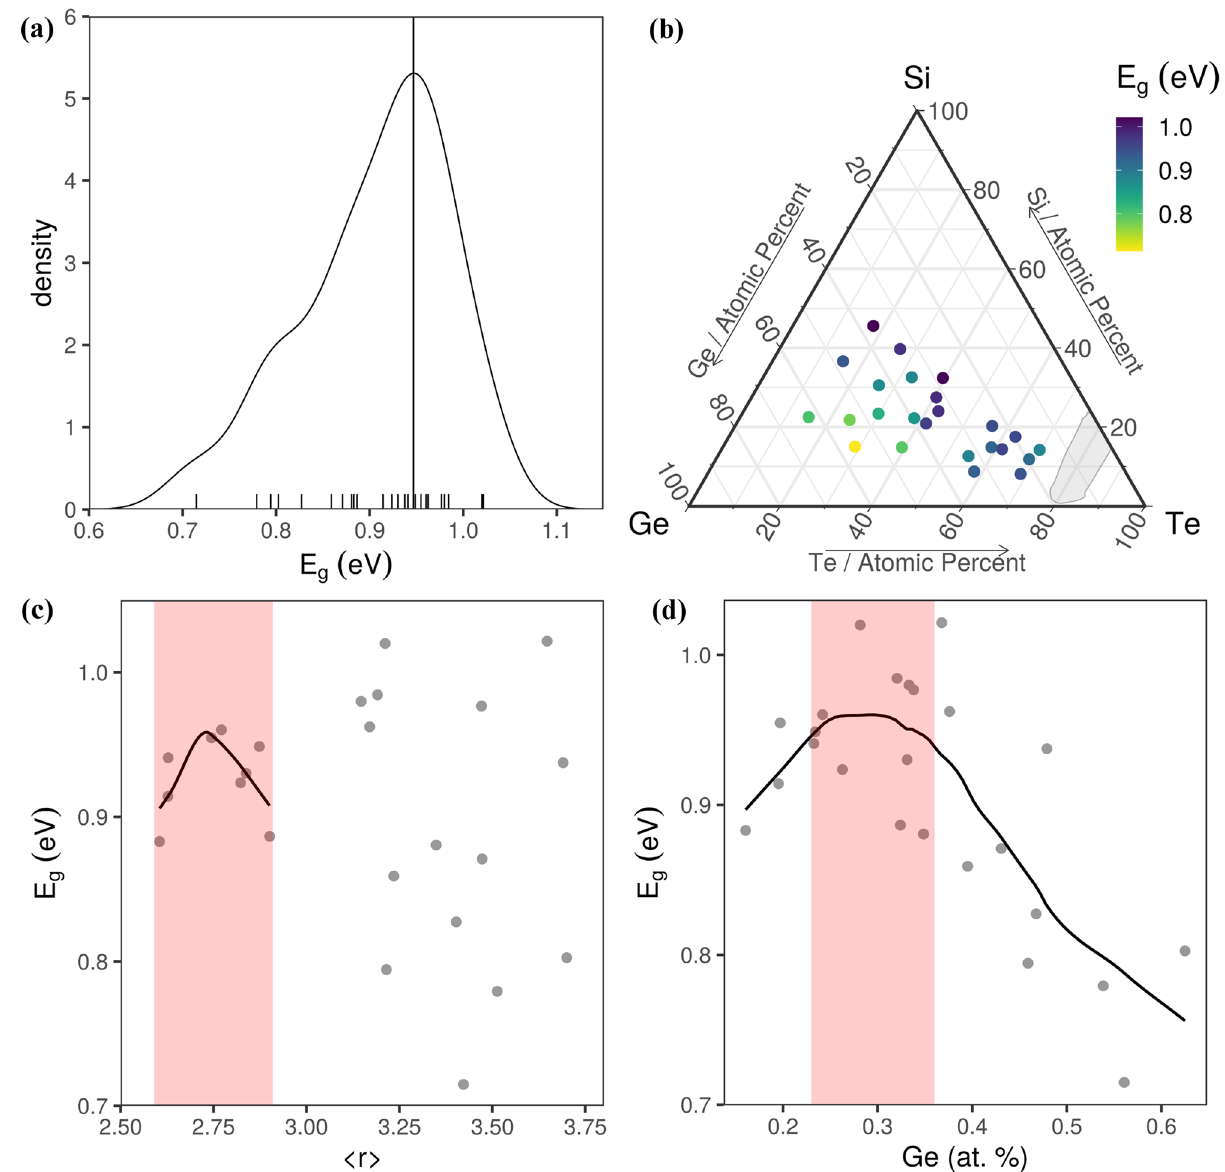
Figure 4. Variation of bandgap in the Si–Ge–Te system. ( a ) The probability density function of E g ; Bandgap as a function of: ( b ) composition, ( c ) the average coordination number, ( d ) Ge concentration. The black lines and red shaded areas in ( c ) and ( d ) are guides to the eye. The ternary diagram in ( b ) was generated with the R software [v. 3.6.3] (R: A language and environment for statistical computing, R Core Team, R Foundation for Statistical Computing, Vienna, Austria (2020) http:// www.R- proje ct. org/.) using the package ggtern [v. 3.3.0] (https:// cran.r- proje ct. org/ web/ packa ges/ ggtern/ index.